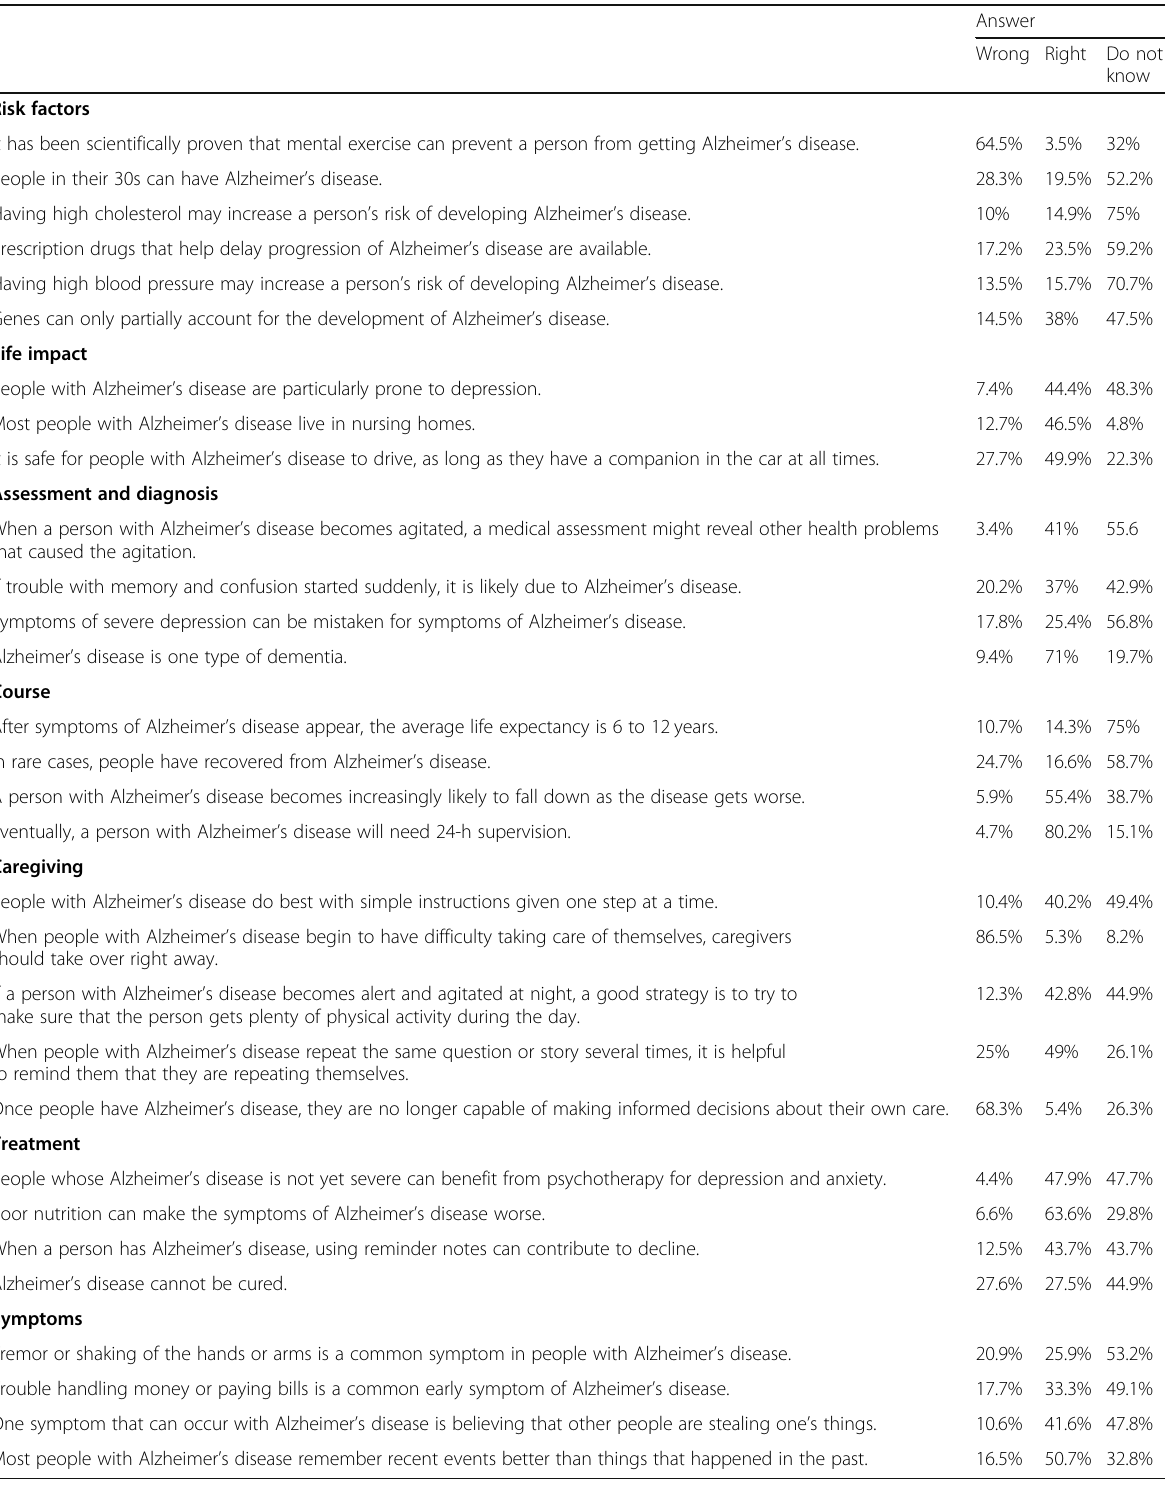
Table 3 Knowledge of Alzheimer ’ s